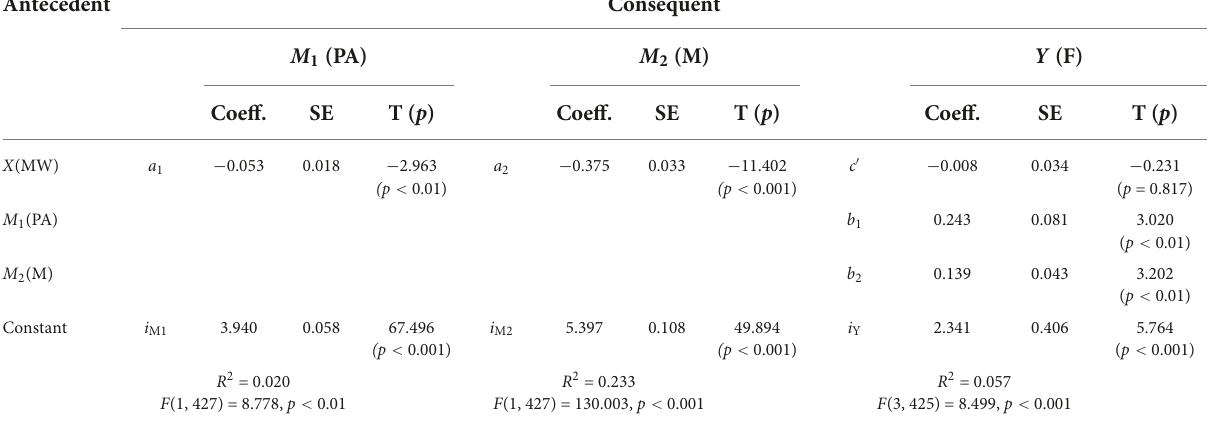
TABLE 2 Regression coefficients, standard errors, and model summary information for the parallel multiple mediator model depicted in Figure 1 .